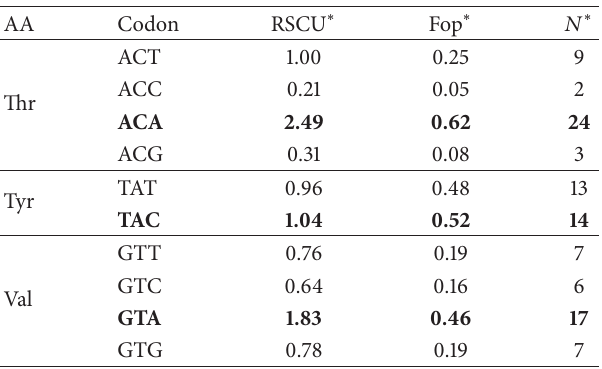
Table 3: Synonymous codon usage pattern in 32 coding